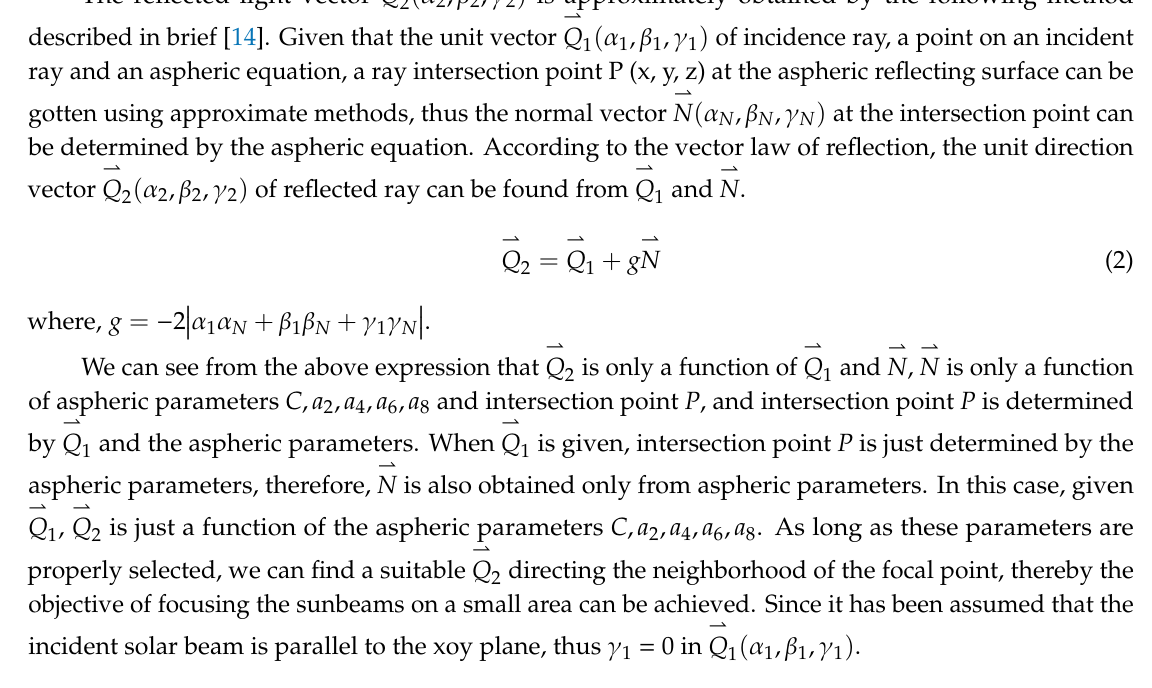
Figure 2. The relative position relation among incident rays, reflected rays and the focus point.